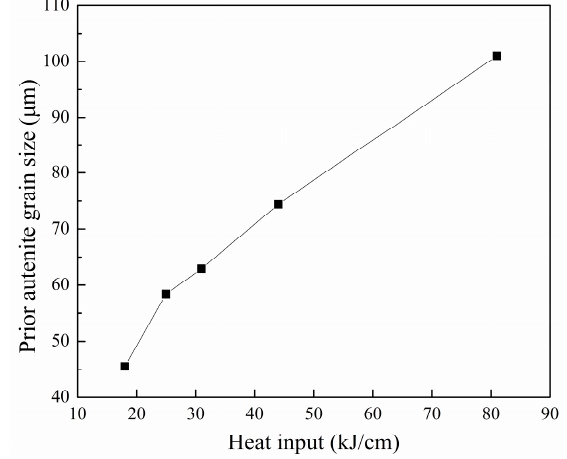
Figure 7. Prior austenite grain size at different heat input.